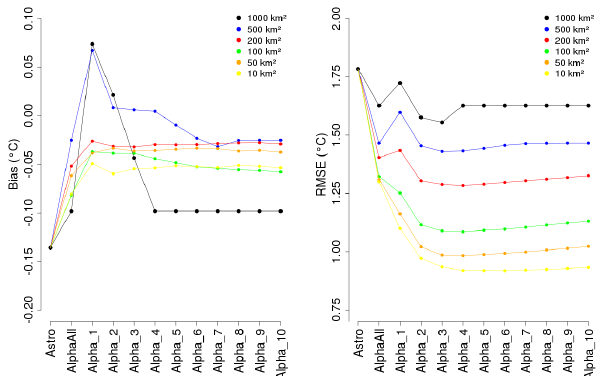
Figure 1. Bias (left) and RMSE (right) of pseudo-observations for hourly temperatures using different methods ( x axis) and different network densities (colours). If we only have N hourly data usable for alpha method, the pseudo-observation for Alpha_M (with M > N ) is set to the Alpha_N ’s